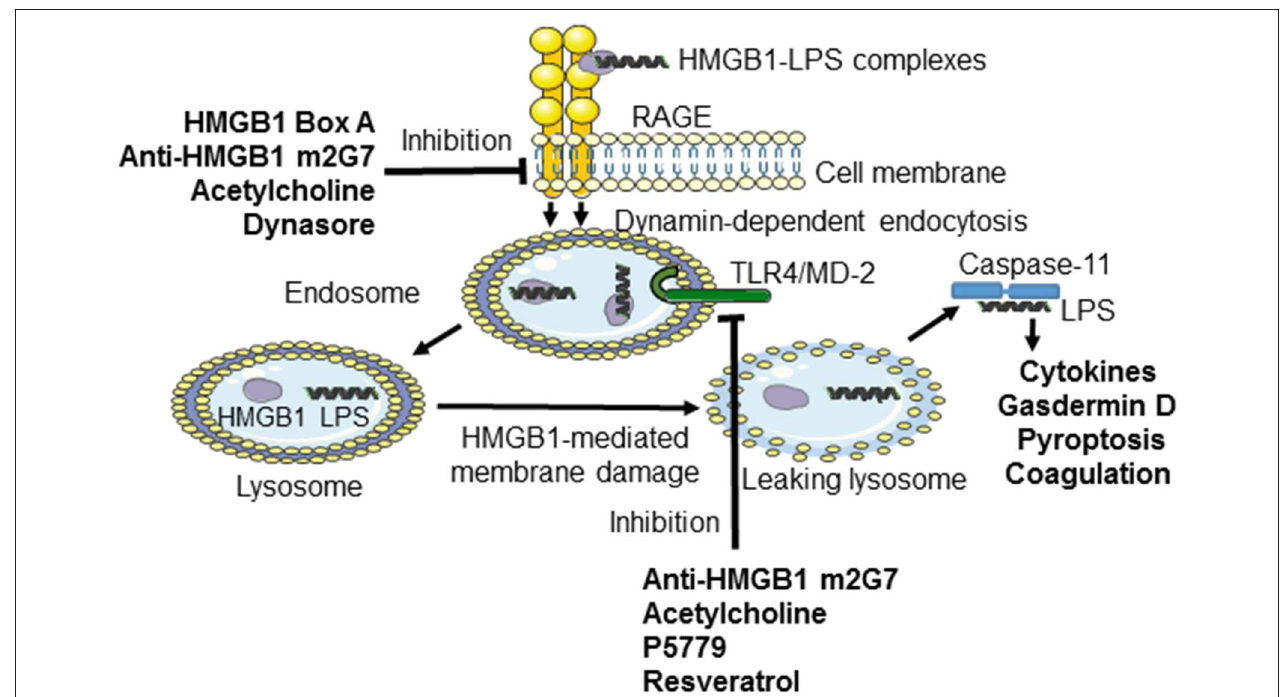
FIGURE 1 | Inhibiting TLR4- or RAGE-mediated effects induced by HMGB1 or LPS-HMGB1 complexes. During endotoxemia, LPS and extracellular HMGB1 forms complexes that are endocytosed via the RAGE-dependent pathway. LPS and HMGB1 activate TLR4 system. The unique contribution by HMGB1 is disruption of the lysosomal membrane enabling LPS to reach and activate its cytosolic receptor caspase-11, which cleaves gasdermin D to form an active oligomer. Activated gasdermin D will subsequently start coagulation and cause cellular pyroptosis in murine macrophages. The HMGB1-specific inhibitors recombinant HMGB1 box A, anti-HMGB1 m2G7, and acetylcholine each inhibits the cellular internalization of LPS-HMGB1 complexes and resultant immune activation. Anti-HMGB1 m2G7 and acetylcholine also inhibit HMGB1/TLR4-mediated inflammation, whereas P5779 and resveratrol selectively block the HMGB1/TLR4 pathway only.